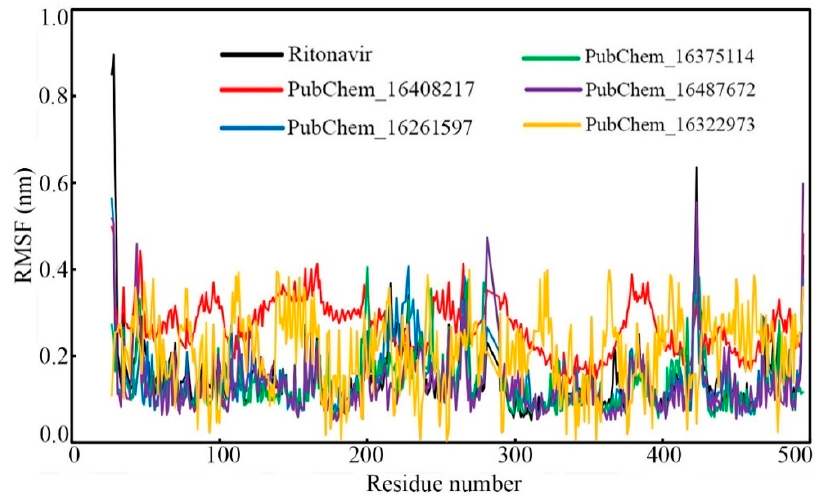
Figure 11. RMSF of individual amino acids of CYP3A5 bound with proposed molecules and RIT.